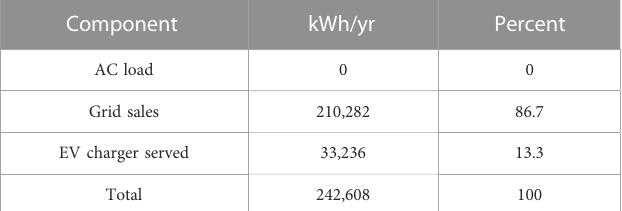
TABLE 11 Electric load details.